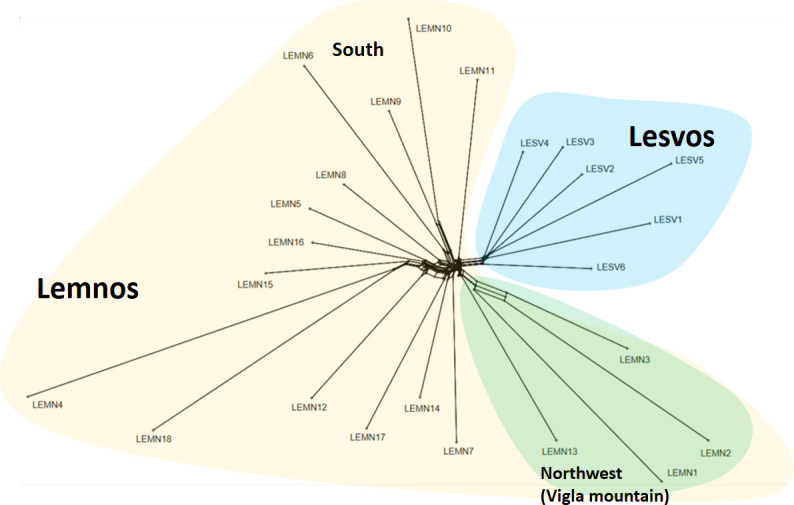
Neighbornet graph of Lesvos and Lemnos sheep based on estimated pairwise Nei’s genetic distances between herds.Yellow background color denotes herds of Lemnos and blue background color herds of Lesvos. For more details, see text. The graph was constructed in SplitsTree5 [14].